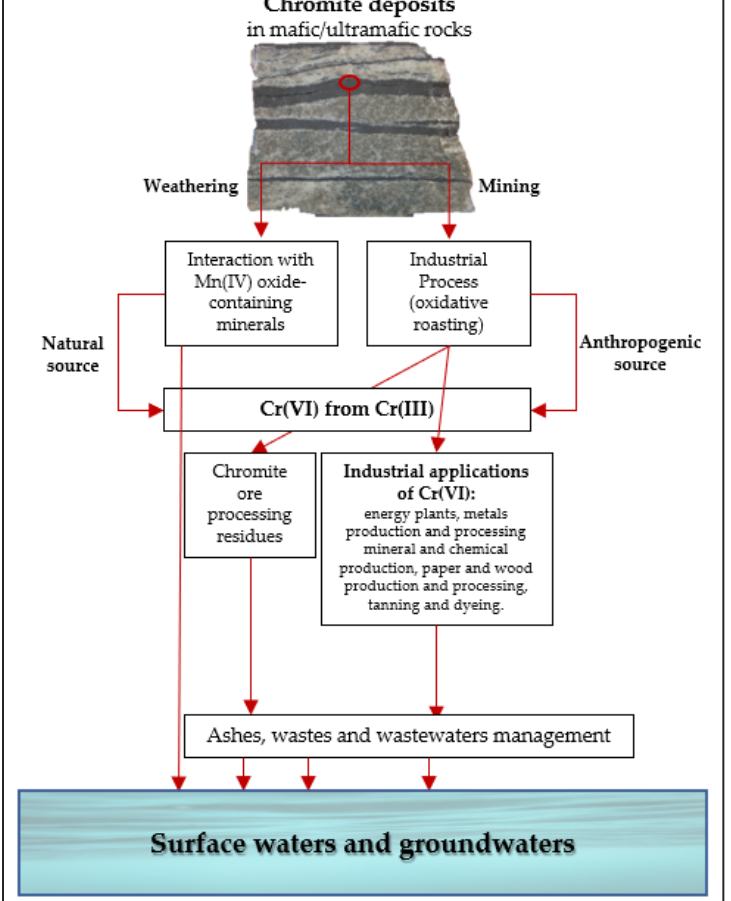
Figure 1. Schematic representation of the main sources of Cr (VI) in waters and groundwaters.